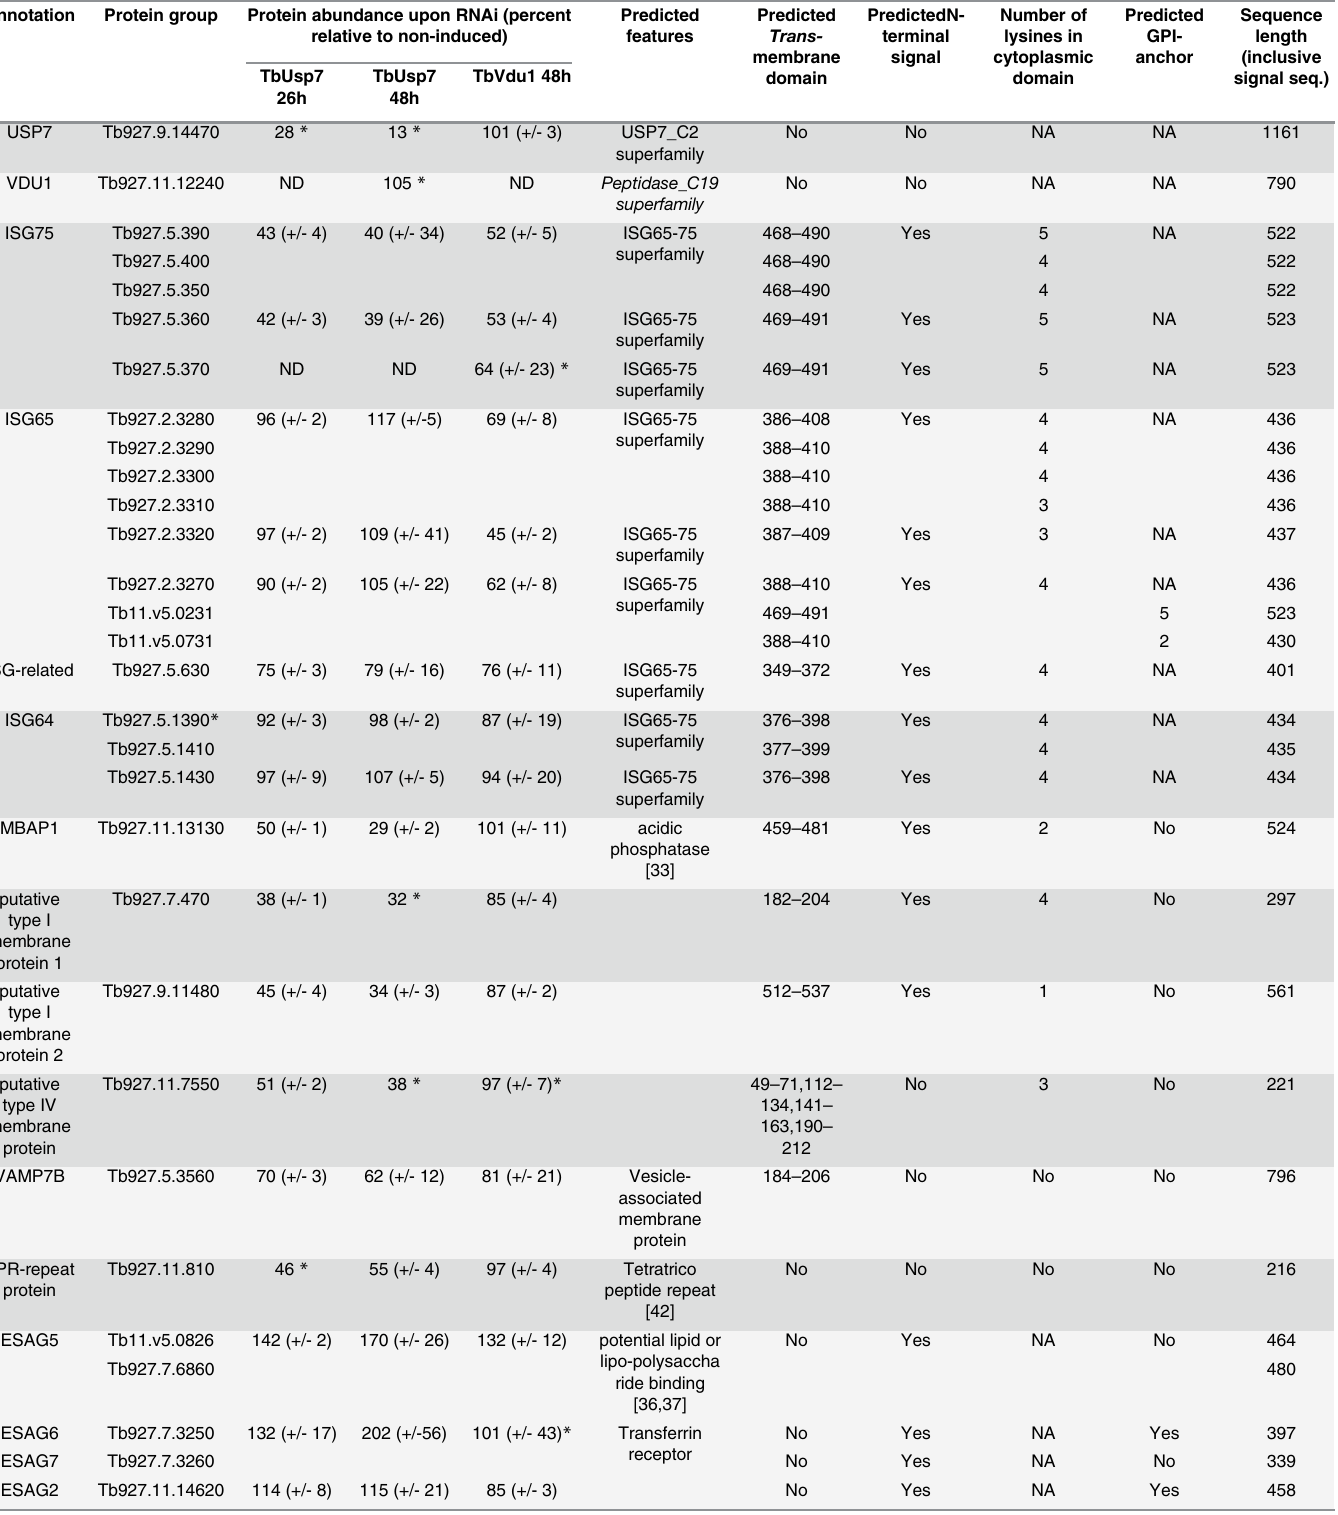
Table 1. Percentage abundance of selected protein groups upon TbUsp7 and TbVdu1 RNAi derived from normalised SILAC